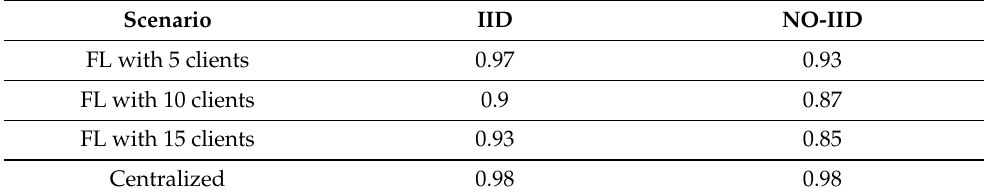
Table 3. Precision achieved for each